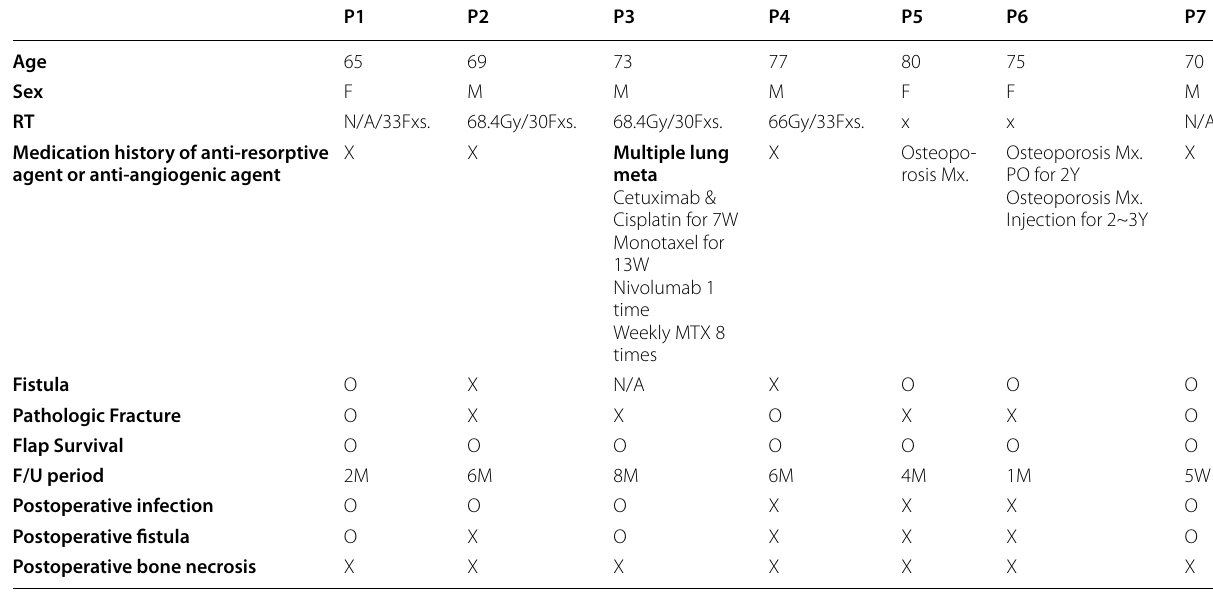
Table 2 Summary of postoperative patient